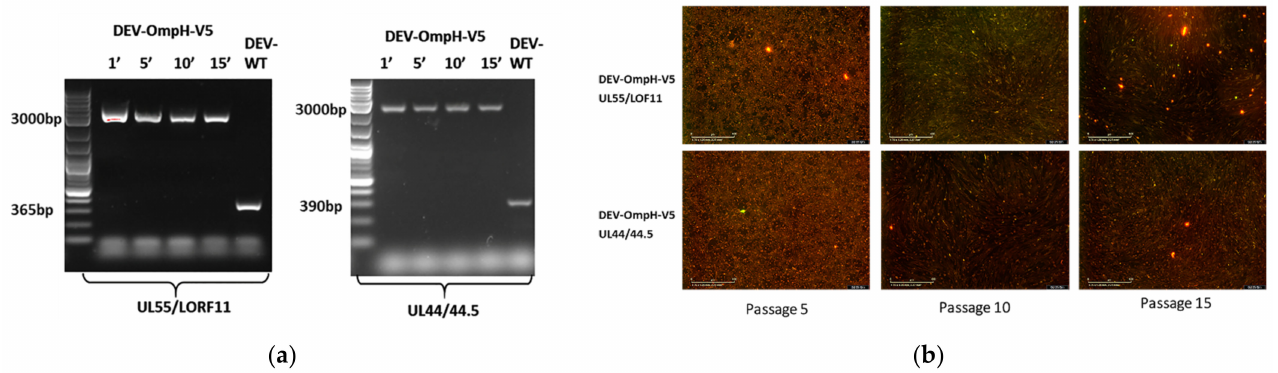
Figure 7. Stability of recombinant DEV-OmpH-V5. ( a ) Detection of OmpH-V5 gene insertion in DEV-OmpH-V5 was confirmed by PCR using primer at both ends of each insertion site during serial 5 passages compared with DEV-WT infected CEF as controls, indicating that the recombinant virus is stable. The lane numbers represent the passage numbers of the recombinant virus. ( b ) Detection of V5 expression of recombinant DEV was assessed by IFA. Merged images of positive double stained DEV-OmpH-V5 infected CEF with anti-V5 (Green) and anti-DEV (Red) was taken by Incucyte at 5th, 10th, and 15th